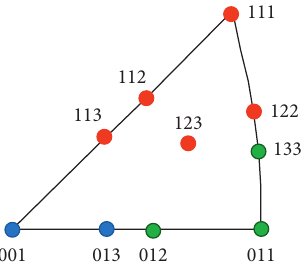
Figure 7: Schematic plot of stereographic projection of different arrangements.